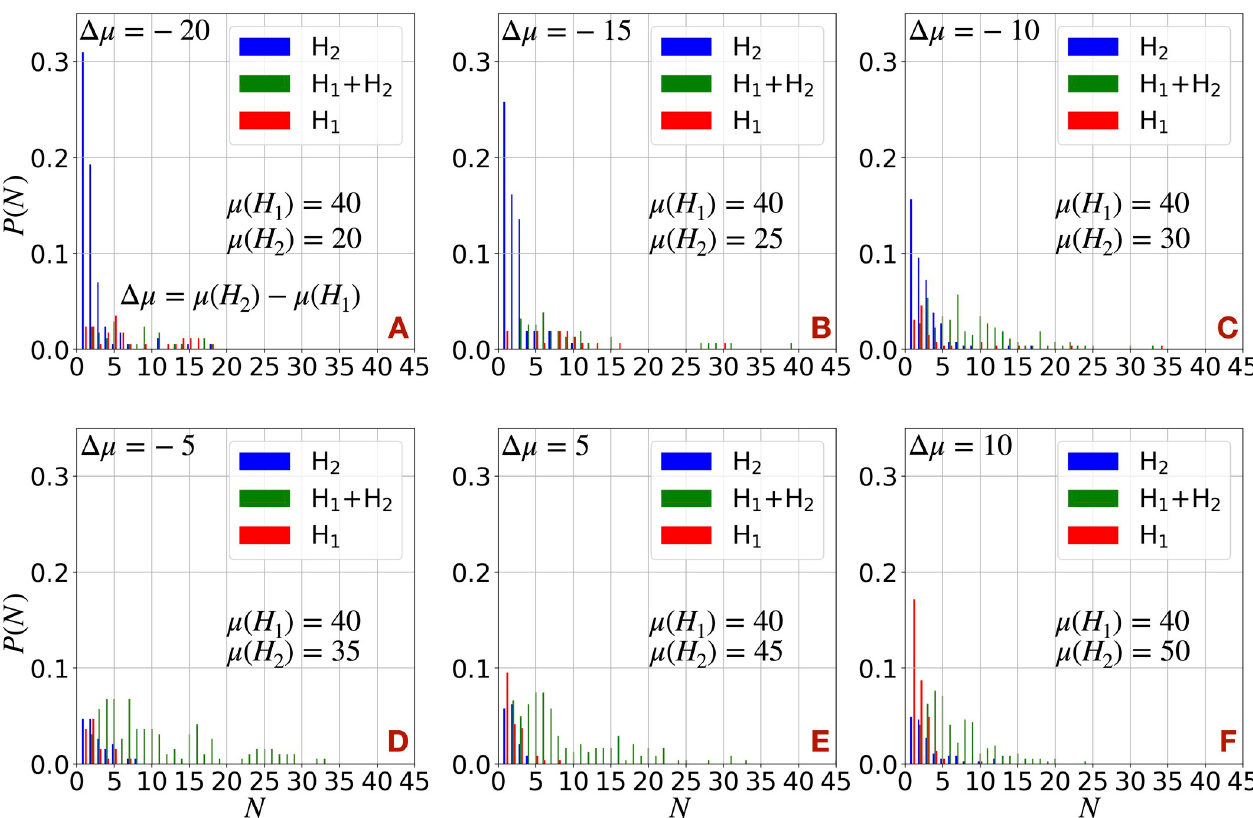
Fig 6. Cluster size distributions in case of heterogeneous clusters. The cluster size distributions ( P ( N )) of H cells in case of two kinds of H cells different in their motile forces at a fixed Γ = 3 for different values of Δ μ = μ ( H 2 ) − μ ( H 1 ) by changing μ ( H 2 ) keeping fixed μ ( H 1 ) = 40. At each N , P ( N ) is split into three bars. Red bars represent the clusters consist of only H 1 cells, blue bars represent the clusters consist of only H 2 cells and green bars represent the heterogeneous clusters consist of H 1 and H 2 cells. The distributions are normalized such that ∑ P ( N ) =